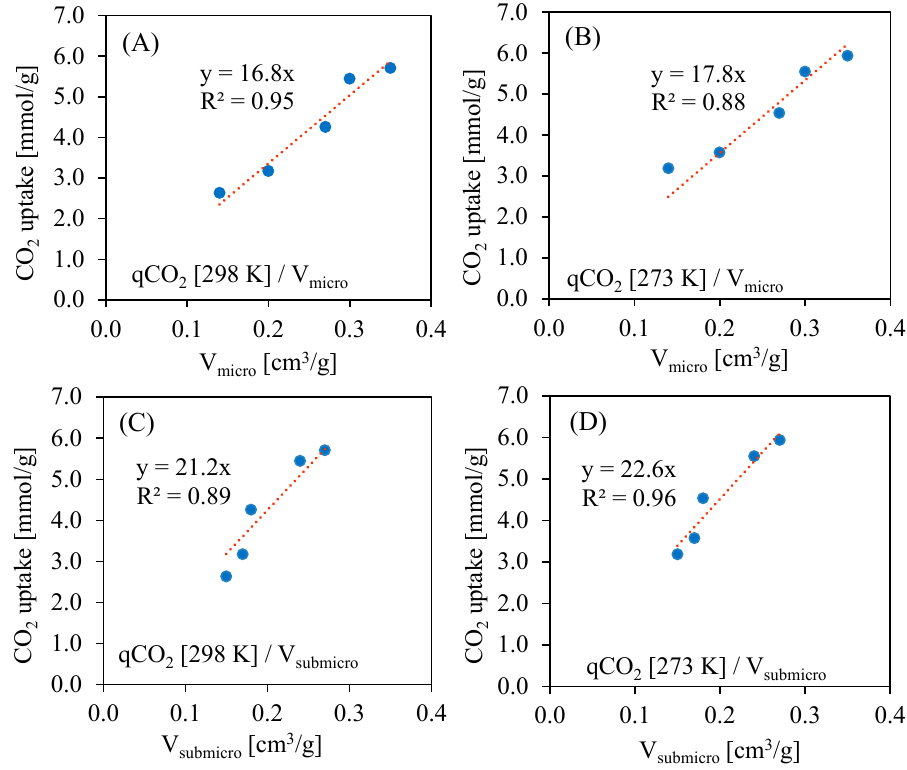
Figure 8. Correlations of CO 2 uptake at 0.95 bar vs. micropore ( A , B ) and submicropore ( C , D ) volumes at 298 K and 273 K.